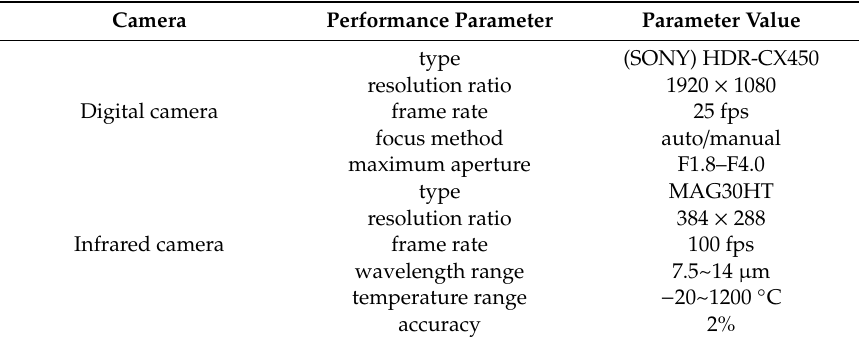
Table 4. Performance parameters of cameras used in this work.